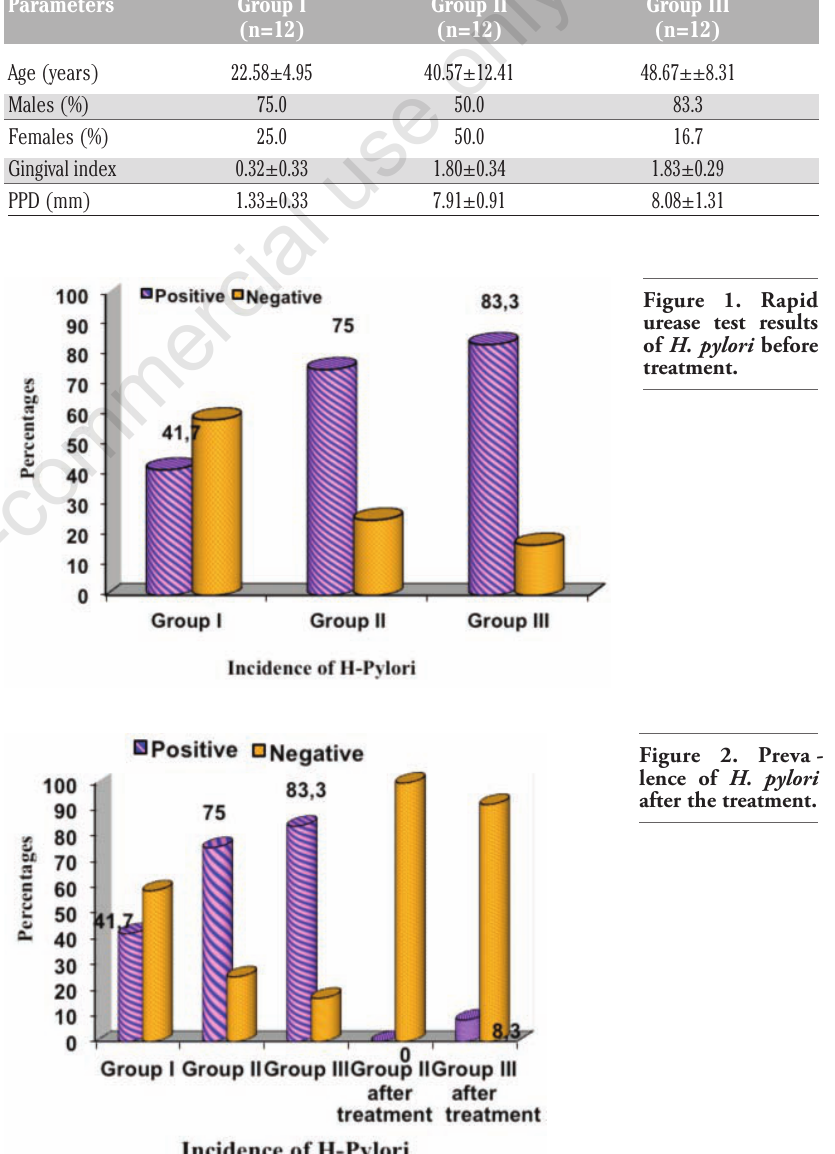
Table 1. Demographic and full-mouth clinical parameters (mean±SD) of Group I, Group II and Group III subjects.